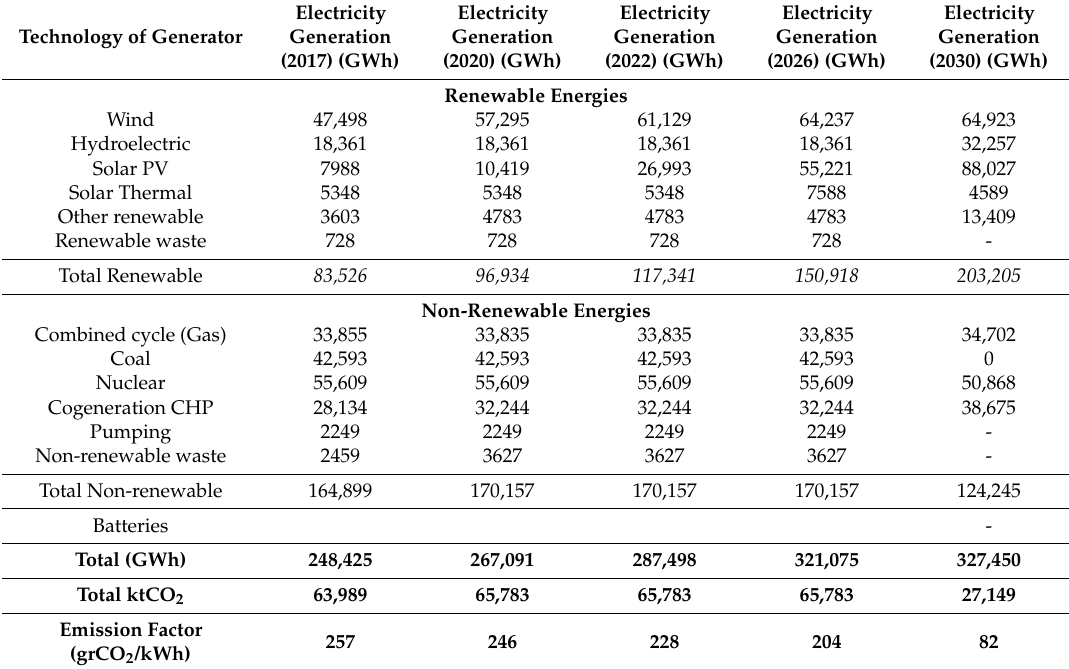
Table 11. Electric generation by the power sources in Spain on the Iberian Peninsula until 2030 [61–64]. Technology of